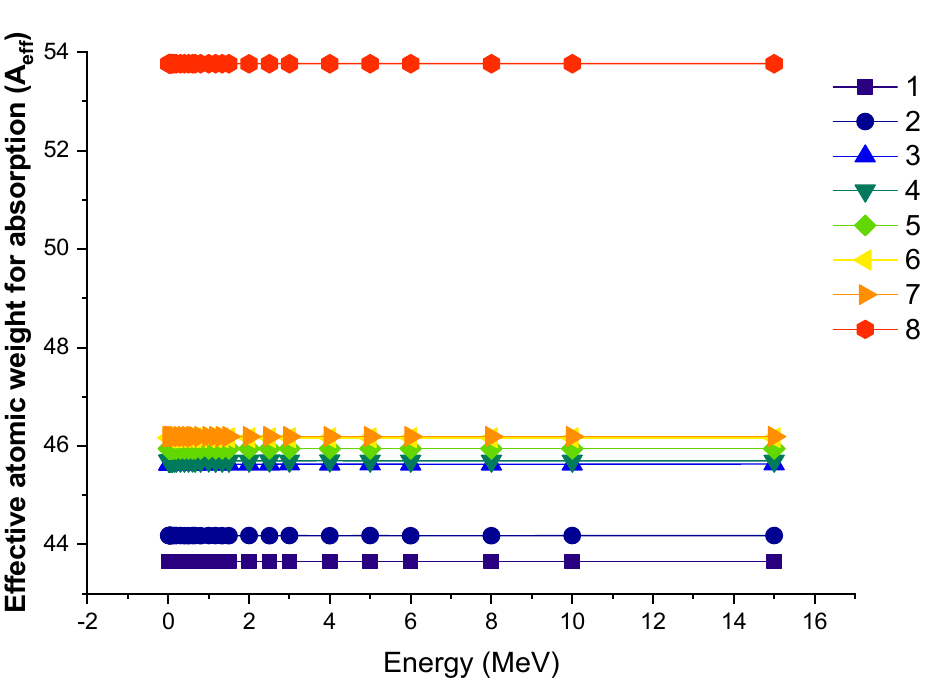
Figure 7. Variation of effective atomic weight (A eff ) against photon energy for all glasses. 1—